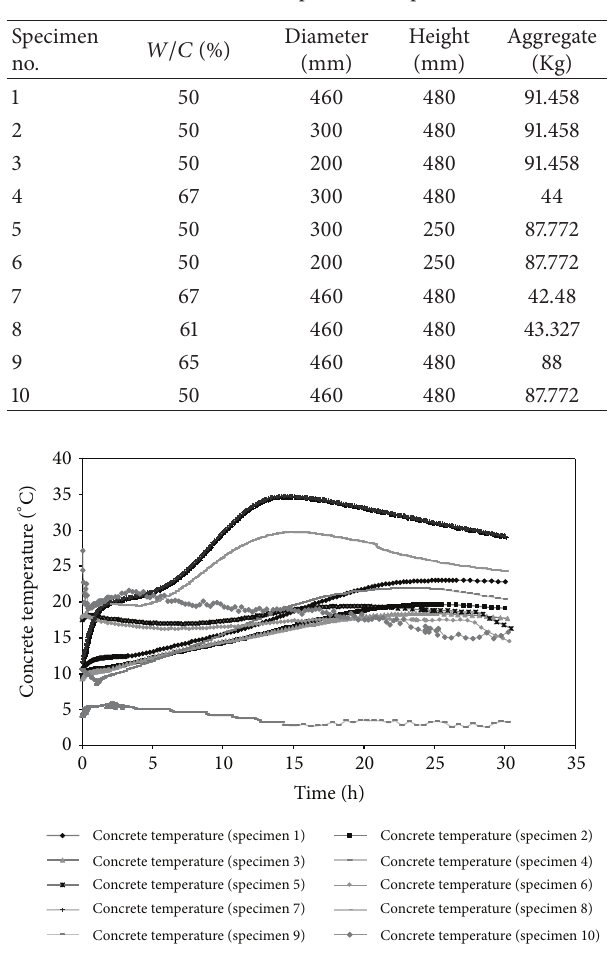
Figure 1: Measured temperature changes during curing for concrete